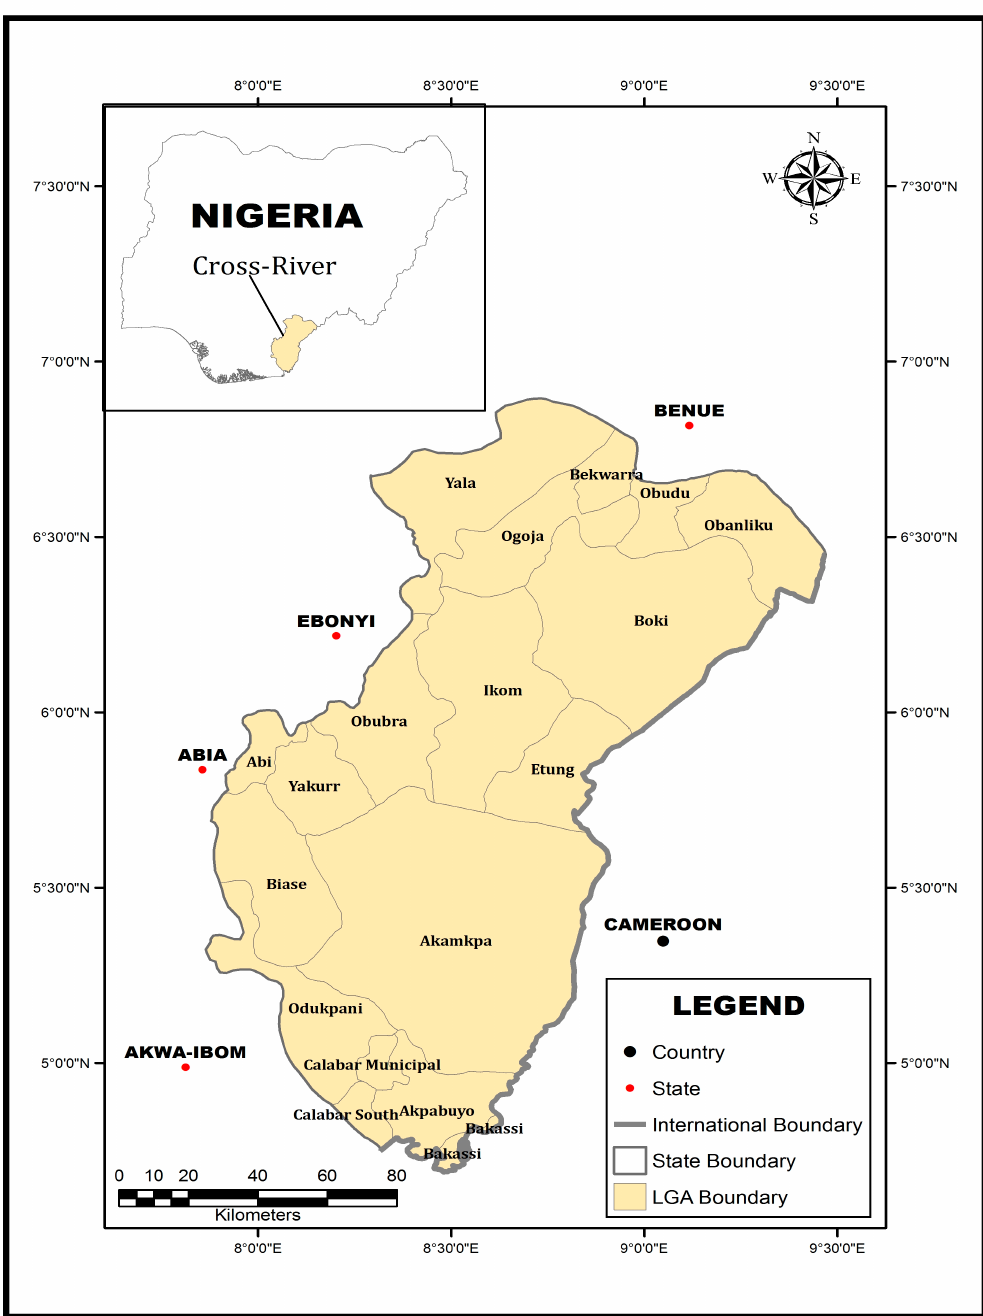
Figure 1. Map of Cross River State showing the 18 Local Government Areas. Source: Geospatial Analysis Mapping and Environmental Research Solutions (2018) .